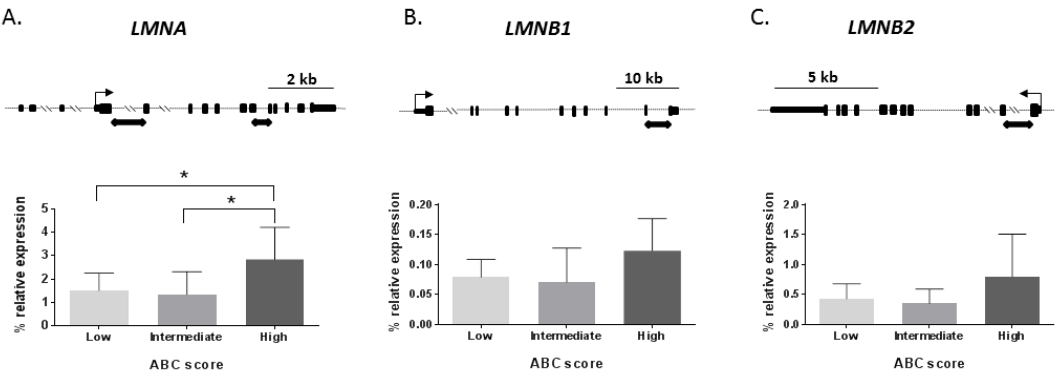
Figure 1. mRNA levels of lamin genes across Alzheimer’s disease (AD) stages. AD hippocampal samples were sorted in three levels [low ( n = 14), intermediate ( n = 6), and high ( n = 8)] of AD neuropathological severity based on ABC score. According to that, mRNA expression levels are shown for each group and gene by bar graphs. The upper row shows the map for each gene. Where black squares represent exons, the thin arrow represents transcription start site for each gene; black rectangular arrow-boxes below the gene map denote amplicons of the RT-qPCR. ( A ) The LMNA gene graph shows a significant increase in expression among ABC stages. ( B ) A statistical tendency ( p -value = 0.052) across ABC stages was found for the LMNB1 gene, the high ABC stage being the one with highest expression. ( C ) The LMNB2 gene did not show any difference between ABC stages. Boxes represent percentage of lamin genes expression relative to the geometric mean of GAPDH and ACTB housekeeping genes expression levels. Bars represent the standard error of the mean. * p -value < 0.05.